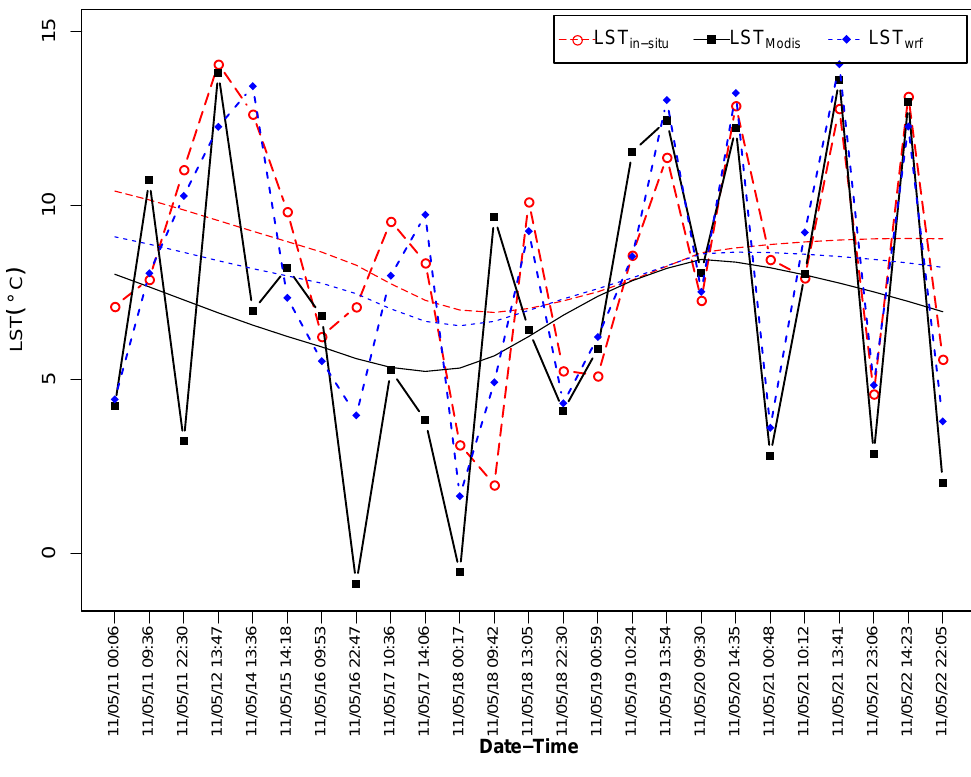
Figure 8. Time-series and trend-lines of LST , LST and LST . Series are produced inSitu Modis wrf by spatially averaging points over various LC types in the study area (except for LST3, which is excluded due to its higher elevation, LST1 to 10 in Figure 1 are used to calculate the averaged LST series). Series only contain the values from times that were coincident Modis with the MODIS LST observations.